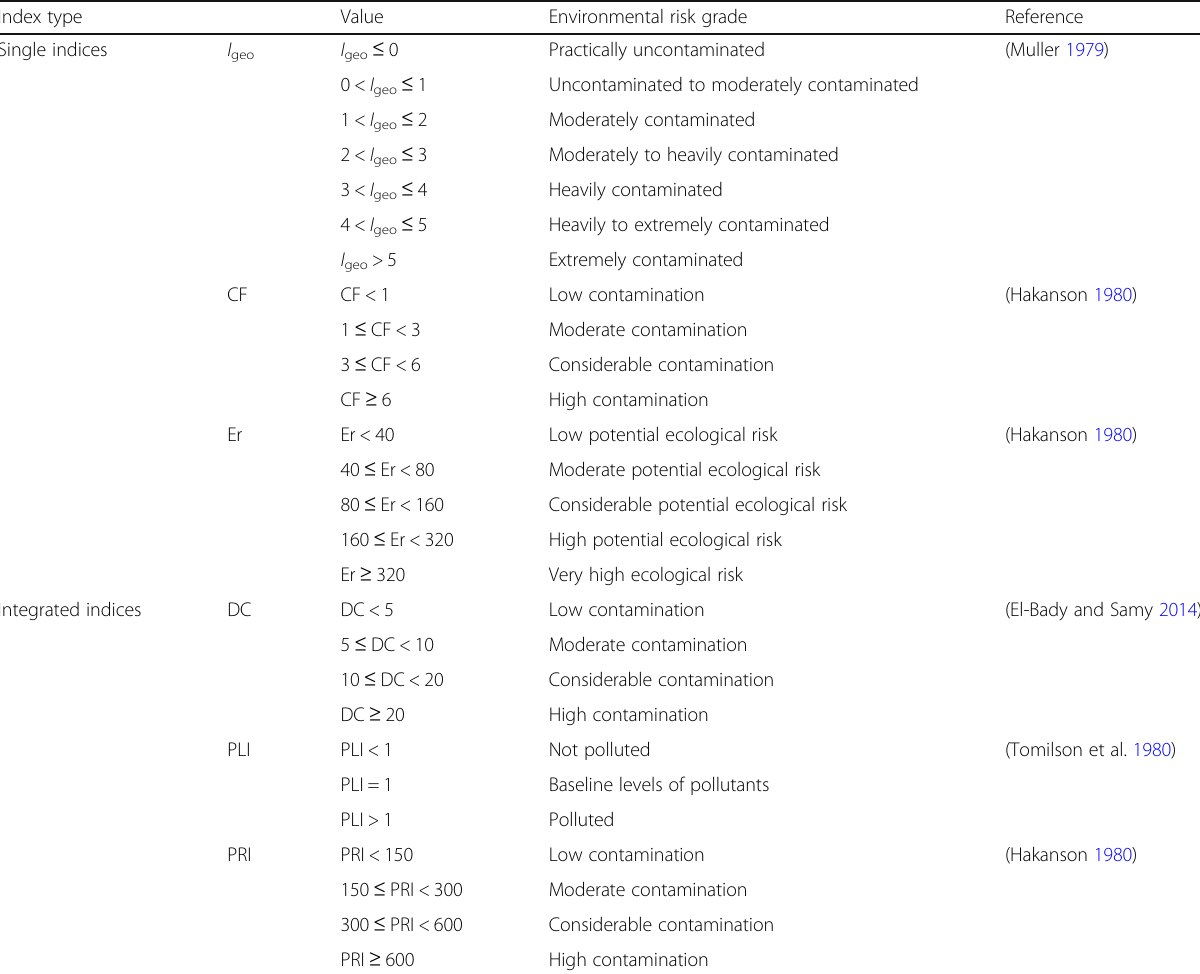
Table 1 I geo , CF, Er, DC, PLI, and PRI